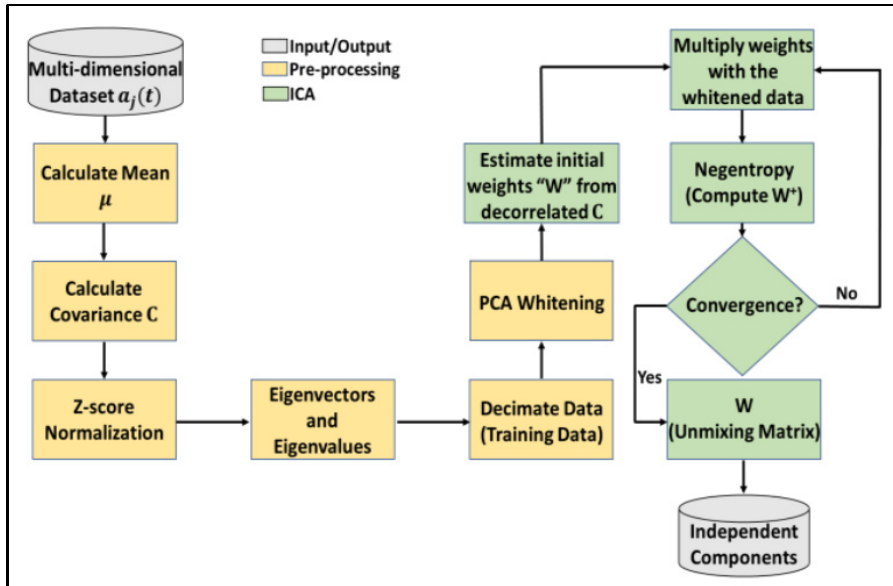
Figure 6. Proposed workflow to apply ICA. Reprinted with permission from [15], copyright Society of Exploration Geophysicists (SEG), 2018.